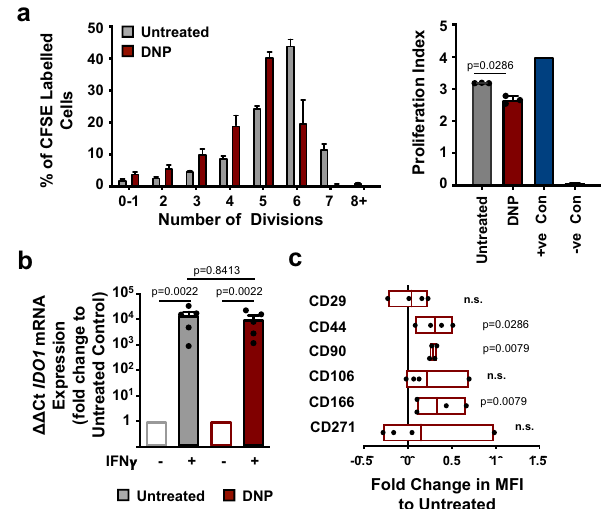
Fig. 4 | Uncoupling oxidative phosphorylation increases MSC immunomodu- lation.a Stro-1 + MSCswereculturedinthepresenceorabsenceofDNPfor14days, then co-cultured with CFSE-labelled, IL-2 and PHA stimulated PBMCs for a further 5 days. Proliferation was assessed by fl ow cytometry. Data in left graph is a repre- sentative experiment ( n =4 replicates per group; mean ± S.D.); data in right graph shows the proliferation index of 3 independent experiments ( n =3; mean ± SEM). b FollowingculturewithorwithoutDNP,MSCswerechallengedwithIFN- γ for24h and IDO1 expression was evaluated by qPCR ( n =1 sample per donor, n =5 inde- pendent donors). c Fold change in MSC surface marker expression following DNP treatment, relative to untreated controls, as assessed by fl ow cytometry (at least 5000 cells per sample from n =4 independent donors). Floating box plots show meanwithhighandlowvalues(CD29,min − 0.227max0.2319mean0.0446;CD44, min0.0853max0.51276mean0.3106;CD90,min0.2485max0.3313mean0.2906; CD106,min − 0.0182max0.6987mean0.2195;CD166min0.1042max0.6667mean 0.2906;CD271min − 0.2814max.0987mean0.14892).Means±SEMandnumberof donors (N) are shown for each condition. Multiple comparisons ( a and b ) by two- way ANOVA with Tukey ’ s multiple comparison test or direct comparisons by two- tailed student T-test (Mann – Whitney) in ( c ). *** p ≤ 0.0001; * p <0.05; n.s., non- signi fi cant. Source data are provided as a Source data fi